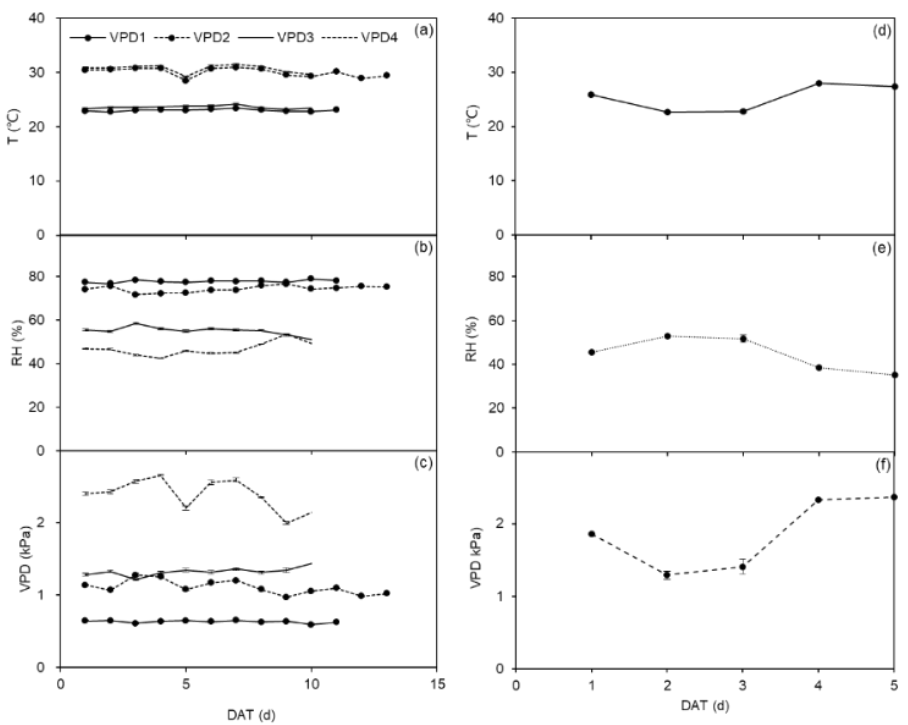
Figure 7. Mean daily temperature (T; ( a , d )), relative humidity (RH; ( b , e )), and vapor pressure deficit (VPD; ( c , f )) in greenhouse cells and field conditions during the experimental period. Error bars indicate the standard error of the mean ( n = 16). DAT denotes days after onset of treatment.